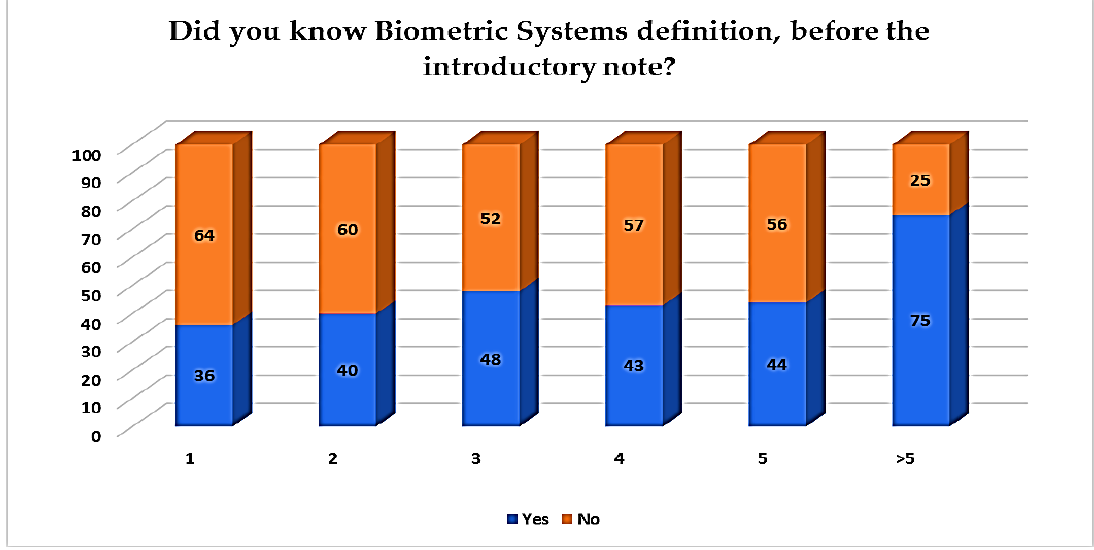
Figure 4. Previous knowledge of BS per year study of undergraduates.